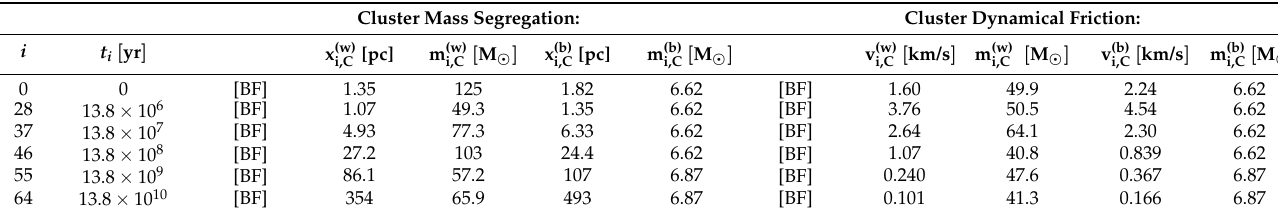
Table 16. Cluster mass segregation and dynamical friction from Figure 13. BF values for the mass segregation ρ j ( x ) plots, where j = w,b for the mass-weighed and bare (homogeneously weighted) and dynamical friction ρ j C , m C , t i distributions, respectively, from which we extract the BF values at selected times. Cluster Mass Segregation: Cluster Dynamical